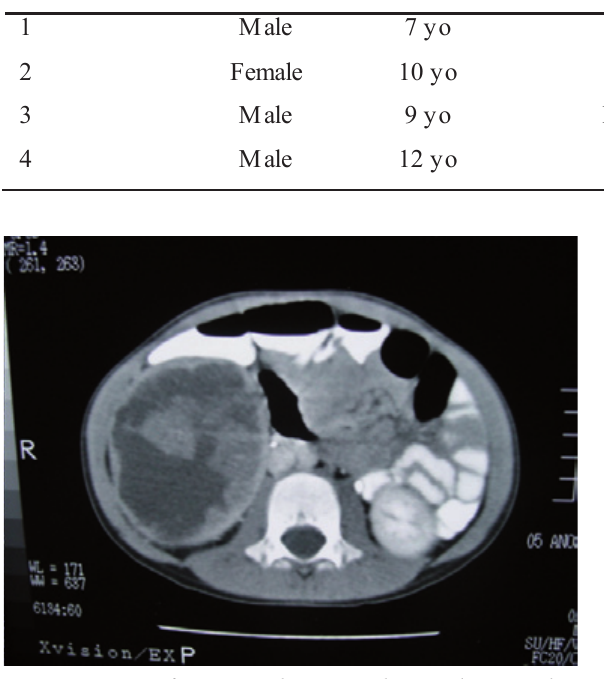
Table 1 - Summary of reported cases.